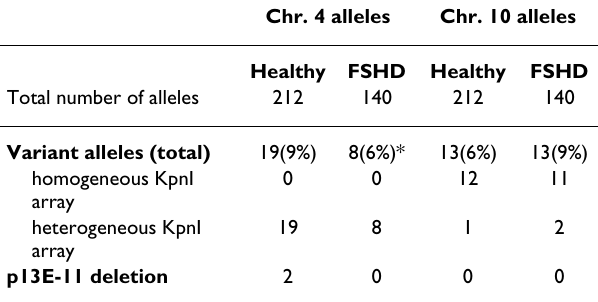
Table 3: Number and type of variant alleles in healthy subjects and FSHD patients Chr. 4 alleles Chr. 10